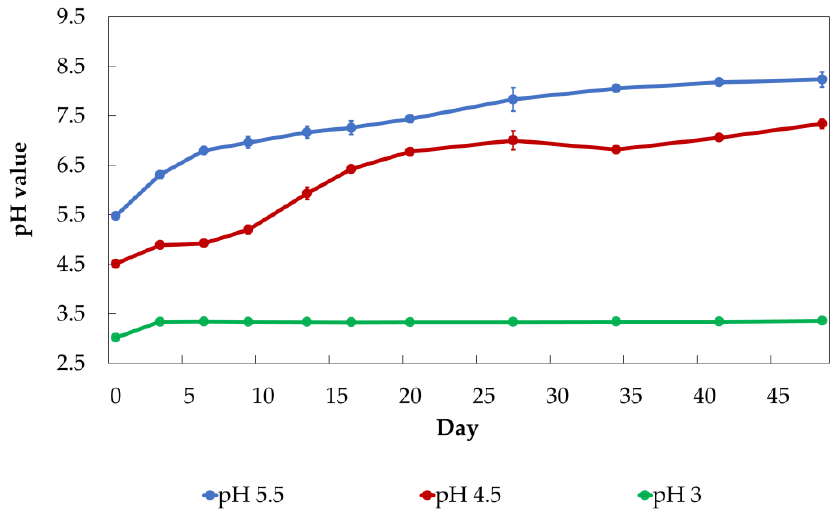
Figure 6. The pH value of dairy cow slurry after acidification with sulfuric acid to pH values of 5.5, 4.5, and 3.0 during the storage period of 48 days (means ± SD, n = 3).